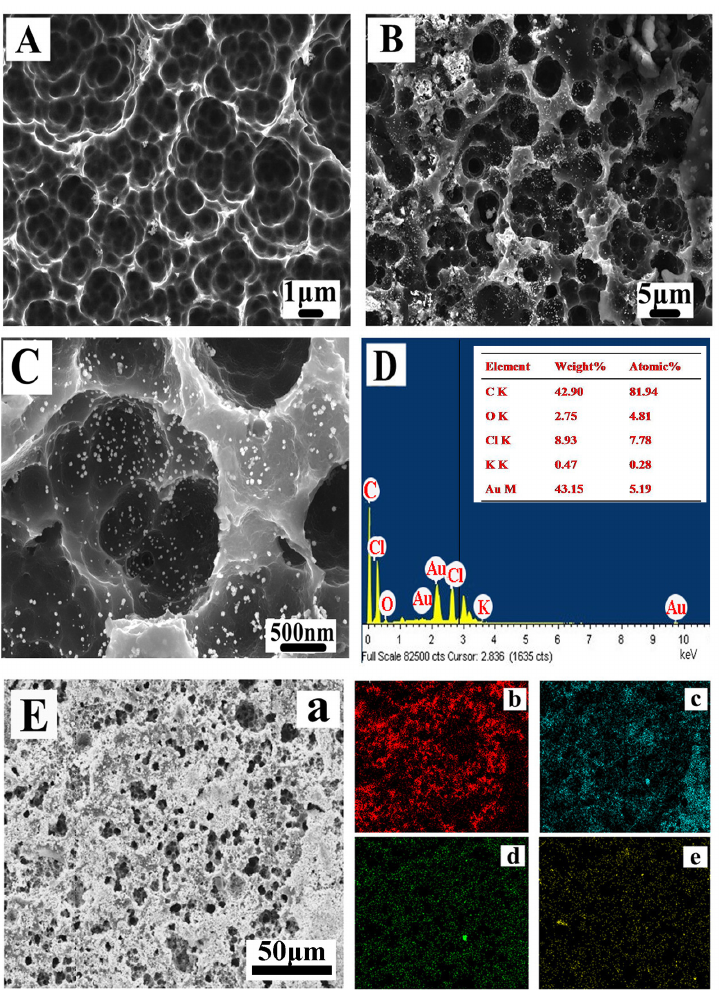
Fig 2. Representative SEM images and EDS elemental analysis of modified electrode. SEM images of CESM-GCE (A) and AuNPs-CESM-GCE (B), (C). EDS elemental analysis (D) and scanning images (E) of AuNPs-CESM-GCE; EDS element scanning image with all elements (a) and elemental distribution of C (b), Cl (c), Au (d) and O